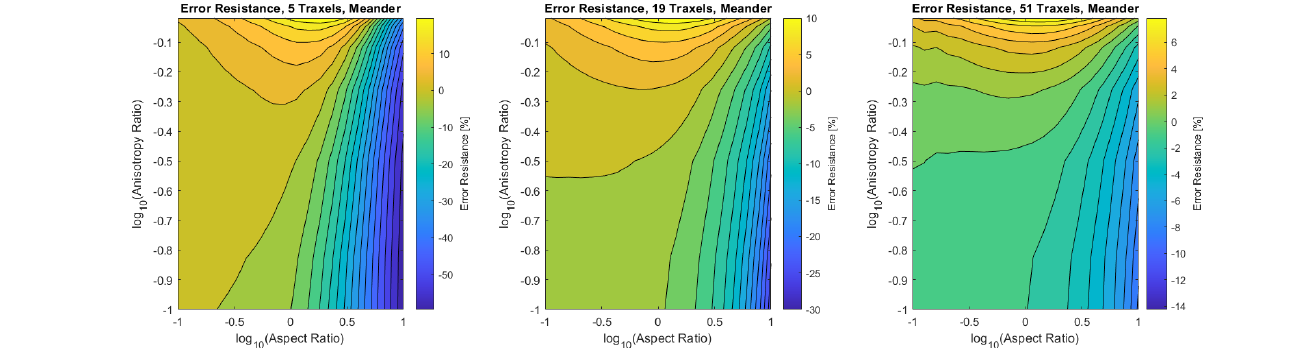
Figure 19. A close-up of the data in Figure 17 for anisotropy ratios close to 1.